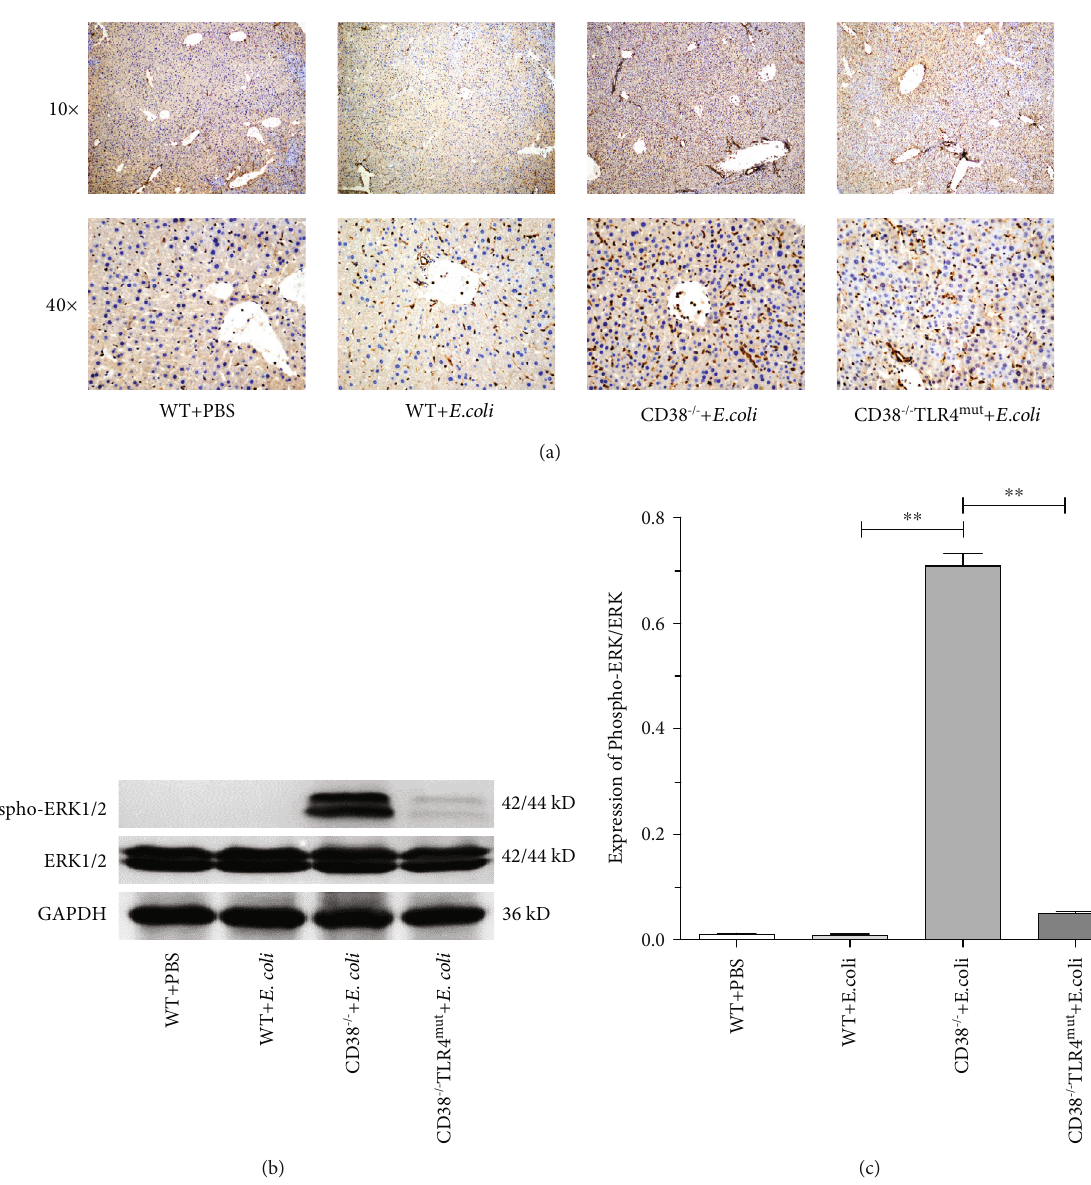
Figure 4: The expression of ERK1/2 was detected in mice induced by E. coli. After 3 hours of bacterial stimulation, liver tissues of WT CD38 -/- and CD38 -/- TLR4 mut mice were taken out to detect the expression of ERK1/2. The liver tissue was stained by immunohistochemistry, and the pictures were obtained by using an Olympus electron microscope (a). The expression of ERK1/2 was detected by Western blot (b), and relative levels of phospho-ERK1/2 to ERK1/2 (c) were analyzed by ImageJ software. Data are presented as means ± standard deviation . Statistical signi fi cance was determined by one-way ANOVA ( n = 3 , ∗∗ p < 0 : 01